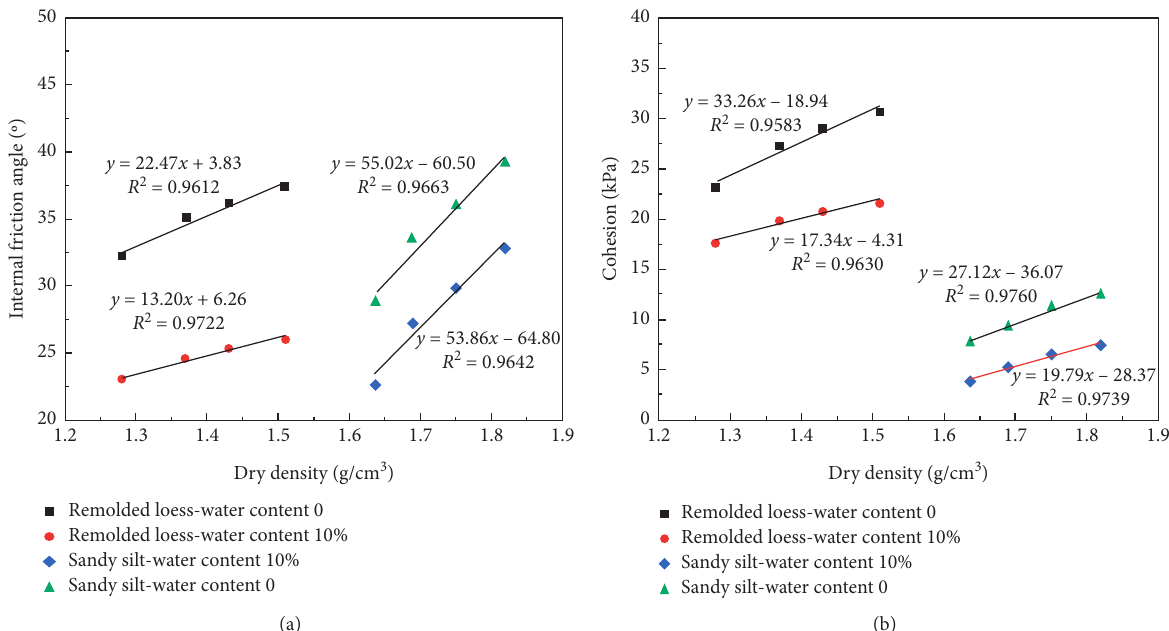
Figure 7: (a) The dry density and internal friction angle diagram of remolded loess, sandy silt; (b) the dry density and cohesion of remolded loess, sandy silt.